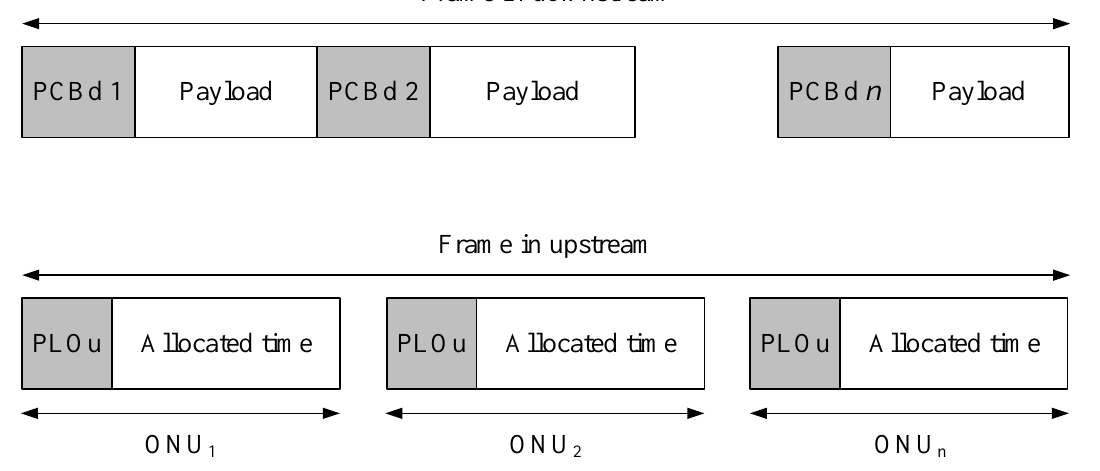
Figure 4. Structure of gigabit passive optical network (GPON) frames